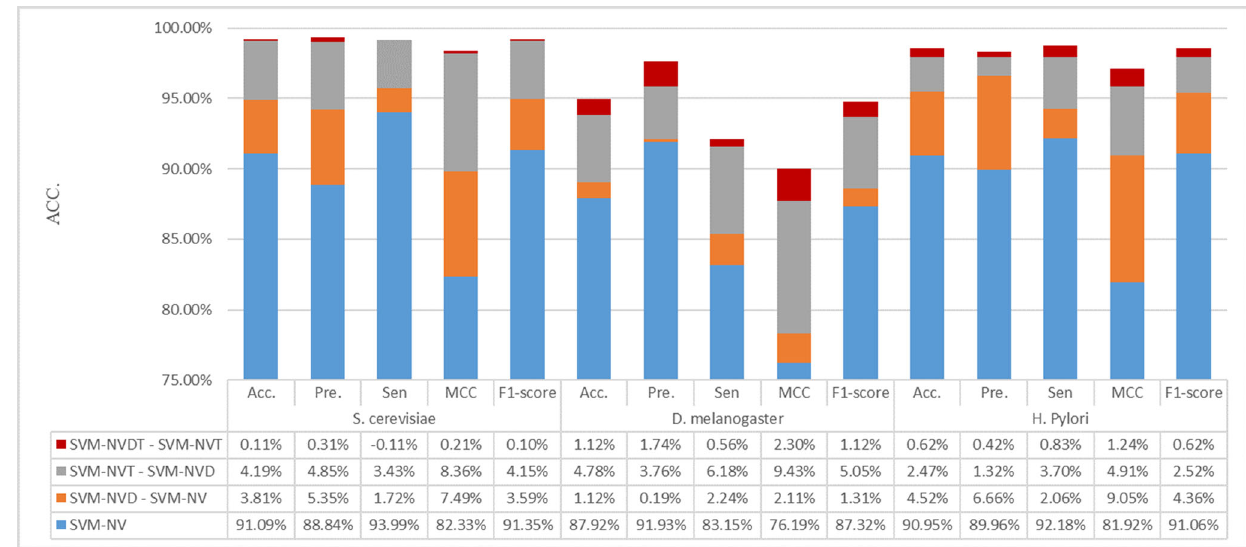
Fig. 2 Prediction performance based on SVM with NV, NVD, and NVDT on S. cerevisiae, D. melanogaster and H. pylori constructed datasets. The abscissa shows the prediction metrics and the ordinate shows the prediction performance.